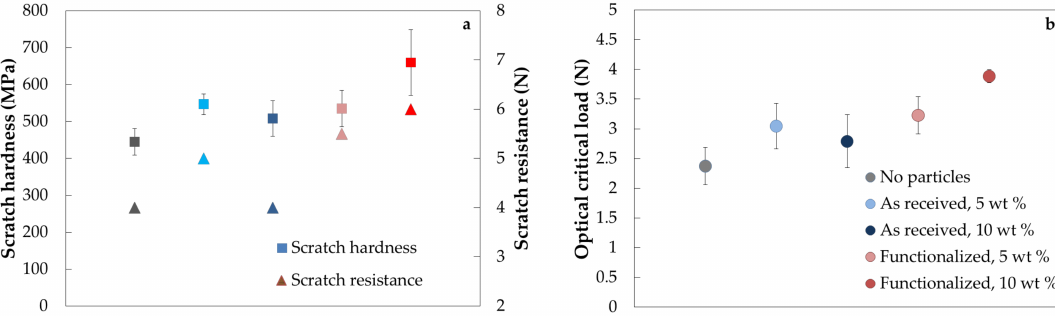
Figure 7. Scratch resistance of the laminates in terms of ( a ) scratch hardness and scratch resistance according to standard BS-EN 438-2, and ( b ) critical loads for the onset of scratch visibility in laminates containing different types of alumina